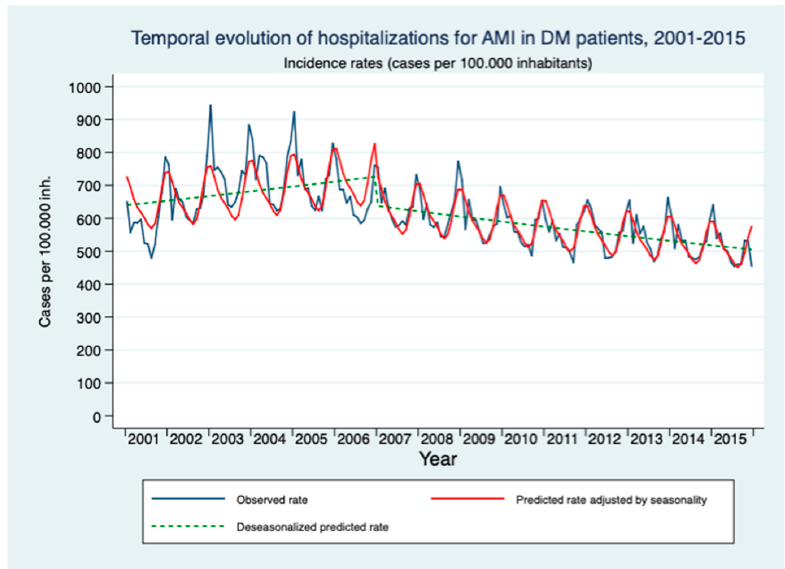
Figure 2. Modeling of the temporal evolution of the hospitalization rate for initial care for an episode of AMI in people over 18 years of age with DM in the period 2001–2015.